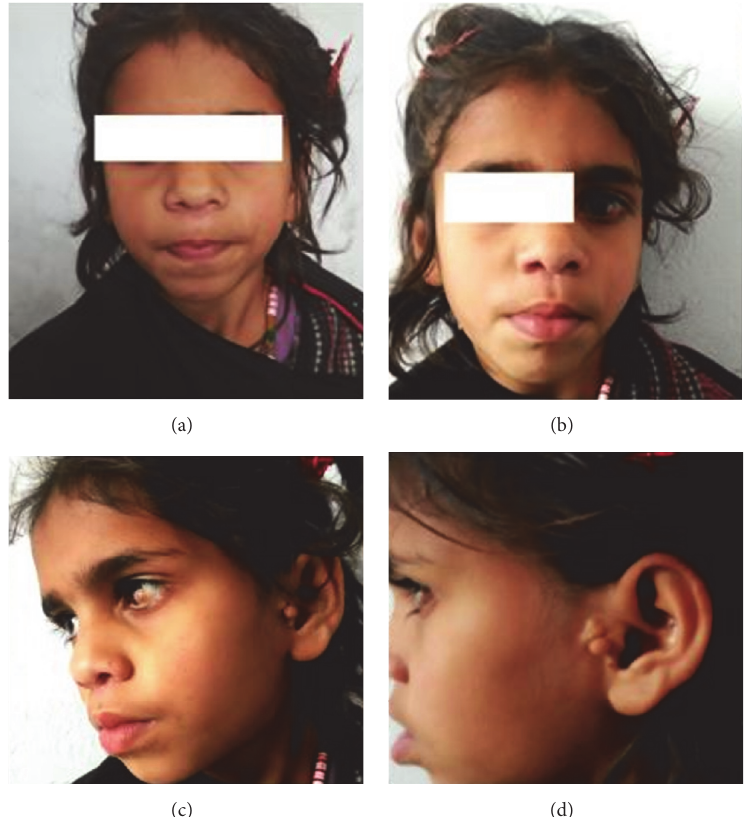
Figure1:(a)and(b)showingfacialdeviationtoleftsidewithleftmandibularhypoplasia;(c)showinglefteyelimbaldermoid;and(d)showing preauricular tag in left ear.